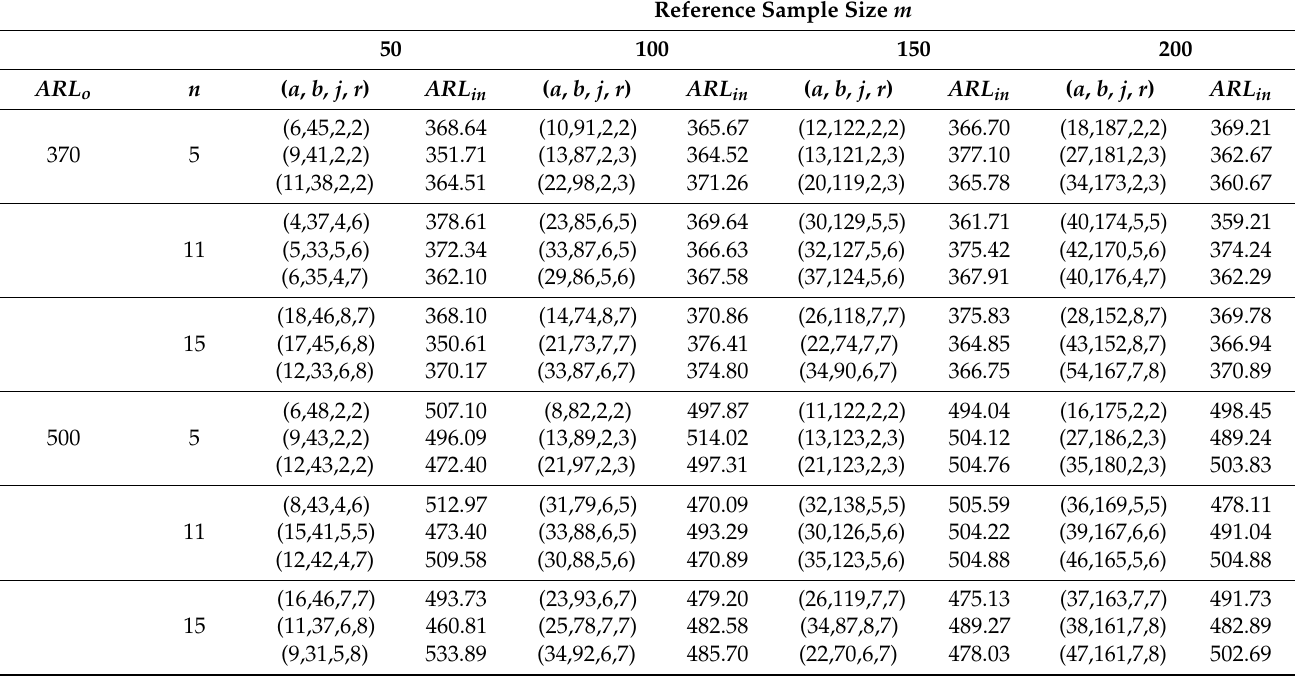
− , C 3 − and C 4 − charts for a given 1 1 1